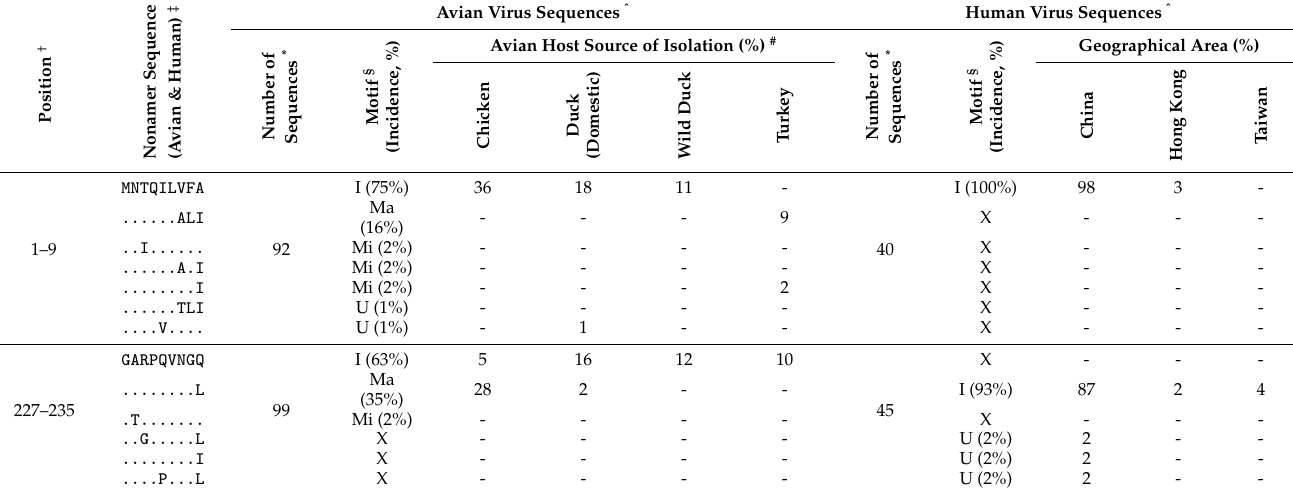
† Amino acid number at the start and end of a nonamer position in the protein alignment. HA protein sequence numeration is based on the H7N9 HA protein sequence alignment. Positions 1–9 with identical avian and human index sequences. Positions 227–235 with a major variant of the avian index selected as the human index sequence. ‡ The nonamer sequence of a given position placed at the top is the avian virus index motif; the remaining sequences below are variants of the avian index sequence. Amino acids identical between the index and the variants are indicated with dots. ˆ All percentages are shown to the nearest whole number. * Number of sequences analyzed: avian, 101; human, 53; however, the numbers can differ from position to position because of the inclusion of partial sequences, besides full-length, in the alignment. § The index nonamer (I) is the most prevalent sequence at a given aligned nonamer position. The motifs differ by one or more amino acids from the index sequence. The major motif (Ma) is the most common variant sequence at the position. Minor motifs (Mi) are multiple different sequences, each occurring more than once and with an incidence less than or occasionally equal to the major motif. Unique motifs (U) are those that occur only once in the alignment. “X” represents sequences that are absent from the respective host. # Only avian host with at least 10% cumulative incidence of the distinct sequence(s) are